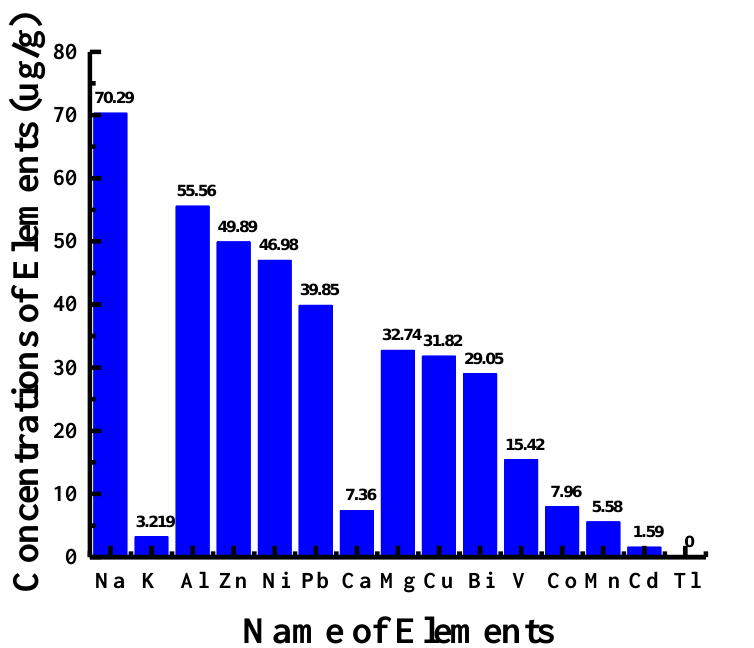
Figure 12. Elemental analysis of RTBD ICP-OES. Table 5. RTBD EA (Elemental Analyser) analysis in comparison with other plant seed and shells biodiesel.